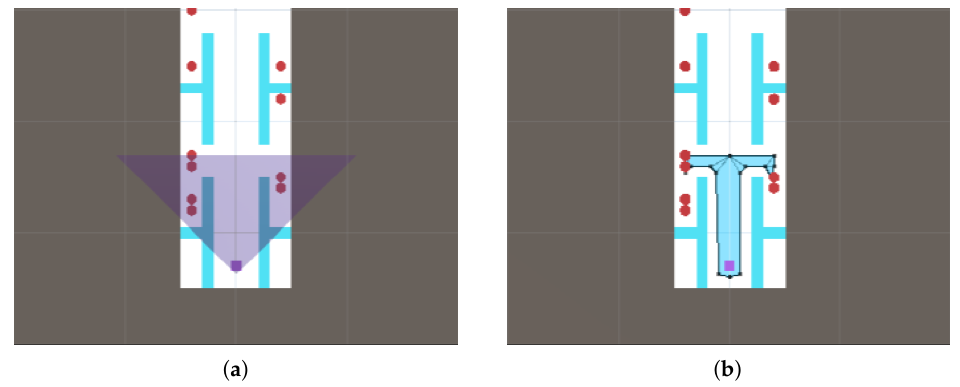
Figure 3. Robot sensor range example: ( a ) Triangle indicating what is perceived with a sensor range of 10 units in the office environment and ( b ) the corresponding NavMesh used by the